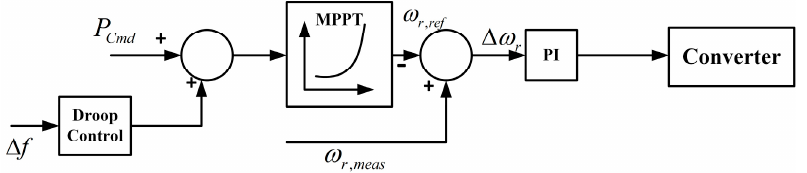
Figure 14. Speed control for wind turbine.